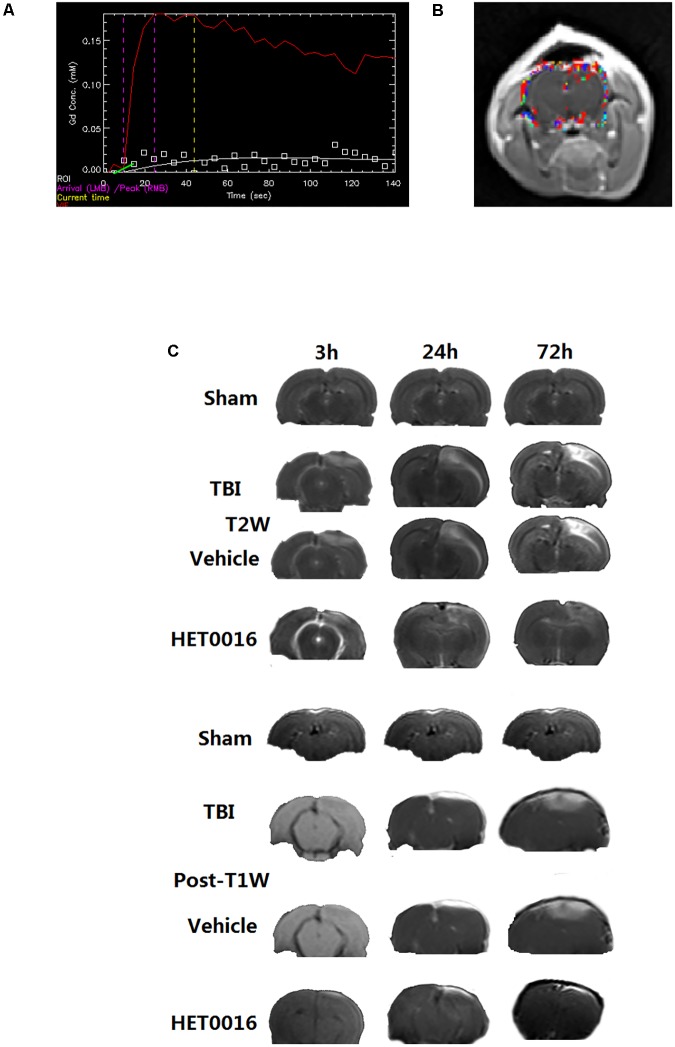
Magnetic resonance imagings (MRIs) from a representative animal. (A) Quantitative analysis of a typical animal brain dynamic contrast-enhanced magnetic resonance imaging (DCE-MRI) with post-processing software (CINEtool; GE Healthcare) 72 h after TBI. The white line represents the lesioned area, and the red line indicates the middle cerebral artery. (B)
Ktrans map of the same animal. The blood–brain barrier permeability is significantly increased at the site of the lesion, and HET0016 administration significantly decreased the blood–brain barrier permeability. (C) T2-WI images show the focal lesion, while the post-contrast T1-WI (post-T1-WI) images show the Gd-DTPA enhancement in the focal lesion area at different time points (3, 24, and 72 h after TBI).